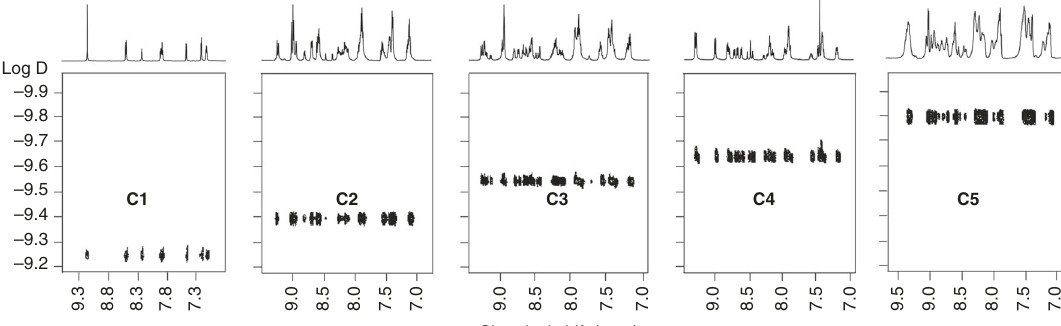
Fig. 5 DOSY NMR spectra of supramolecules C1 –